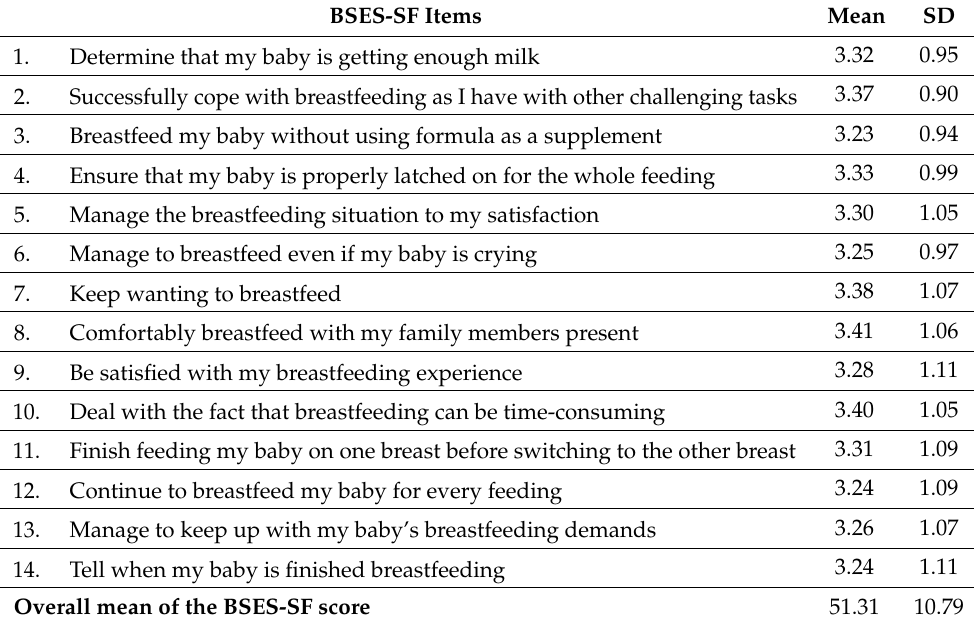
Table 3. Mean scores and standard deviation of BSES-SF items among nursing mothers.